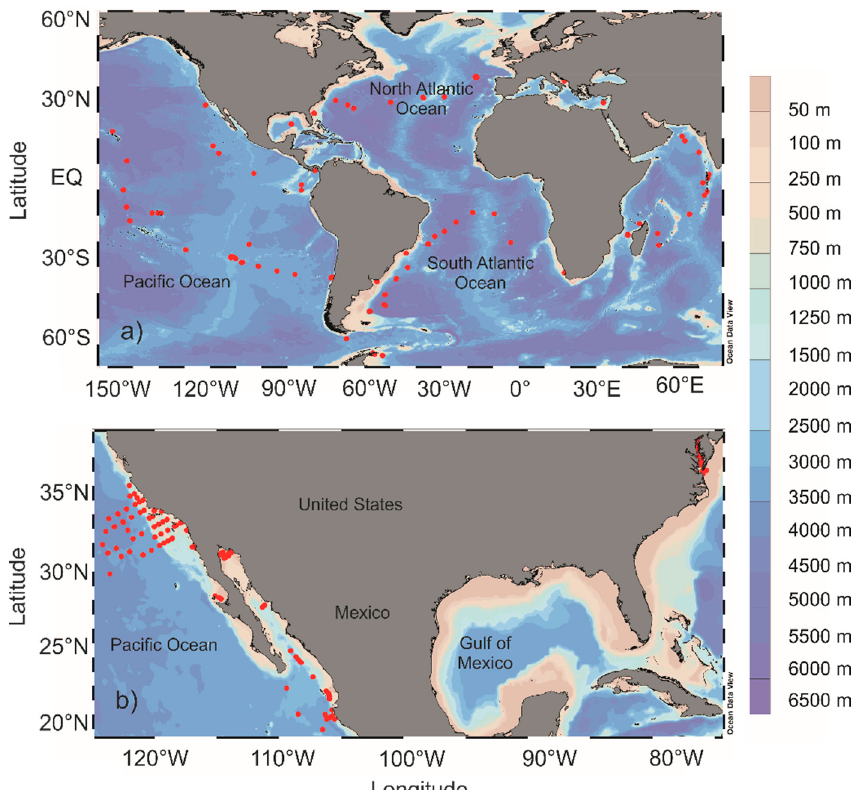
Figure 1. Location of stations; the color bar indicates the bathymetry, in meters. ( a ) Stations of the